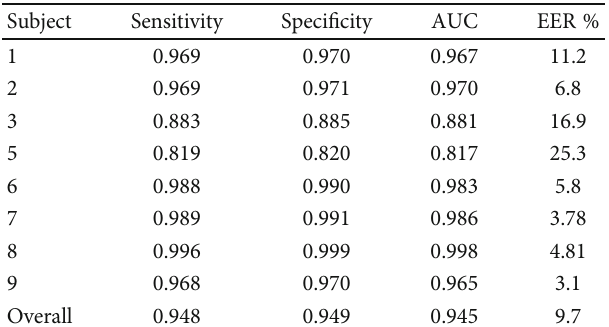
Table 4: The result of sensitivity, speci fi city, AUC, and EER% of subjects 1, 2, 3, 5, 6, 7, 8, and 9. Subjects 4 and 10 have not been taken for